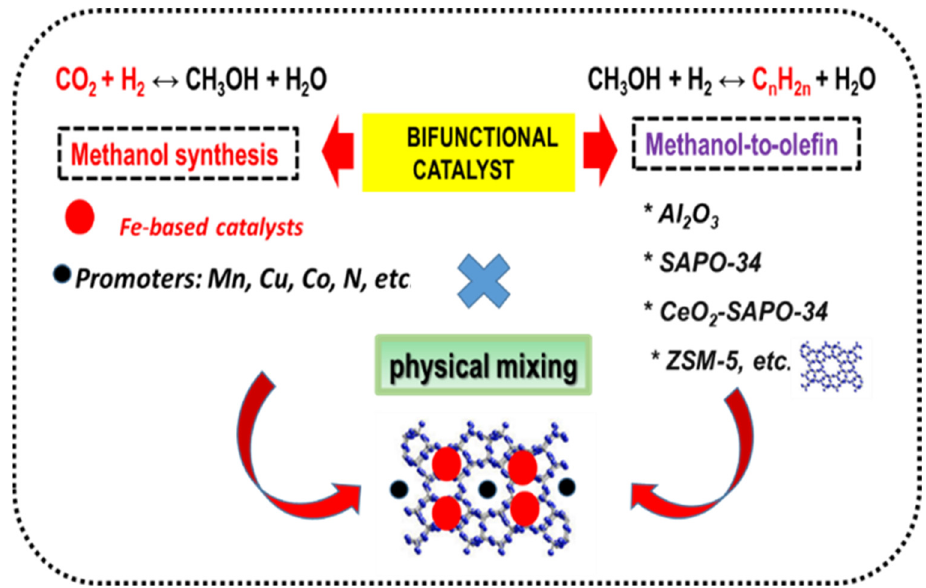
Figure 16. Visualization of the preparation of the hybrid catalyst by physical mixing method. *, supports currently employed.